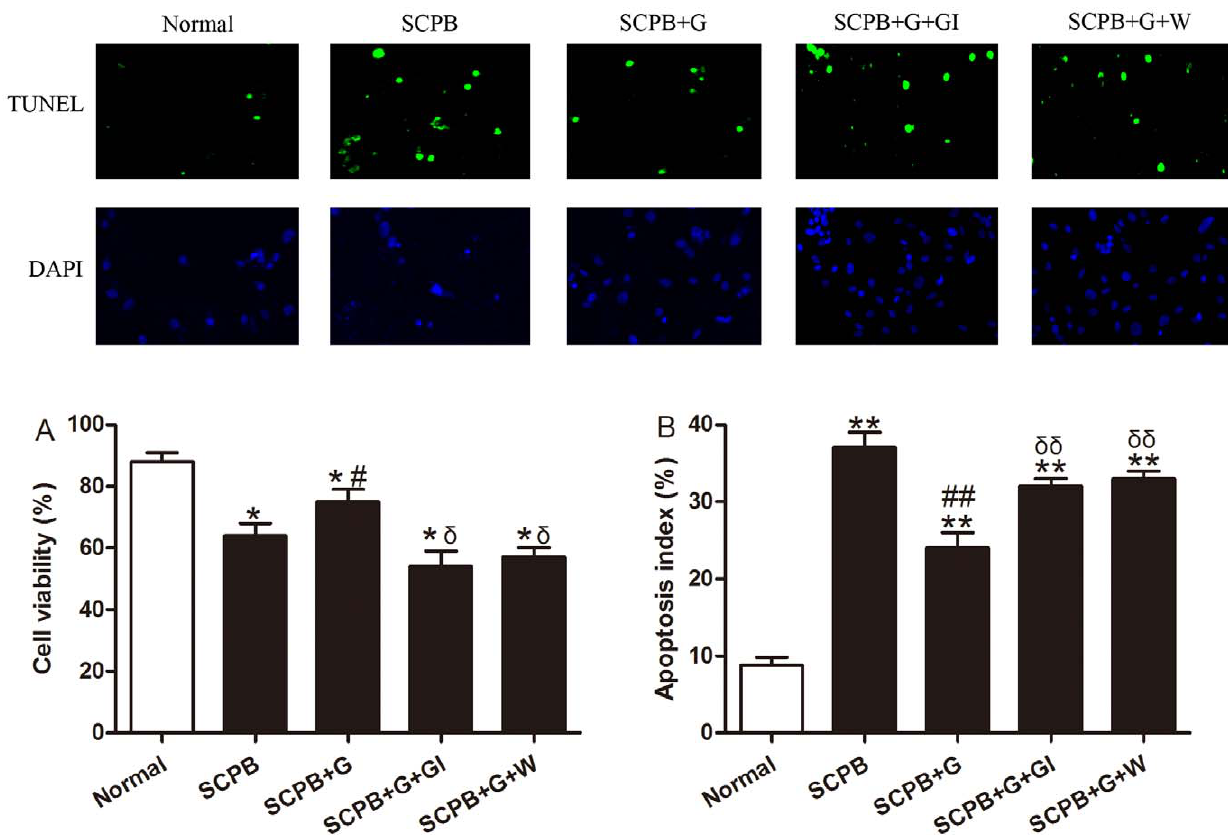
Figure 5. Cell viability and apoptosis of simulated CPB cardiomyocytes following different treatments. A, cell viability measured by MTT assay (n=8). B, apoptosis measured by in situ detection of TUNEL-positive nuclei and apoptotic index expressed as the percentage of TUNEL- positive myocytes (top row) over total nuclei determined by 4 9 ,6-diamino-2-phenylindole staining (bottom row) ( 6 20 objective). (n=8). Values presented are mean 6 SEM. Normal, normal culture condition; SCPB, simulated CPB; G, ghrelin; GI, [D-Lys3]-GHRP-6, ghrelin inhibitor; W, wortmannin, a PI3K inhibitor. ** P , 0.01 vs. Sham, * P , 0.05 vs. Sham, ## P , 0.01 vs. CPB, # P , 0.05 vs. CPB, dd P , 0.01 vs. CPB + G, d P , 0.05 vs. CPB + G.